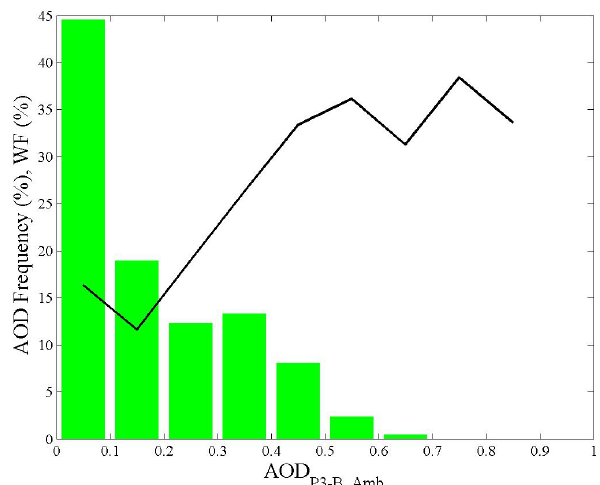
Fig. 9. Frequency of the AOD 550 nm retrieved from ambient extinc- tion coefficient measured aboard the P-3B and the water fraction (WF in percent, black line) calculated using the dry and ambient AOD 550 nm measured aboard the P-3B (see Eq. 7).